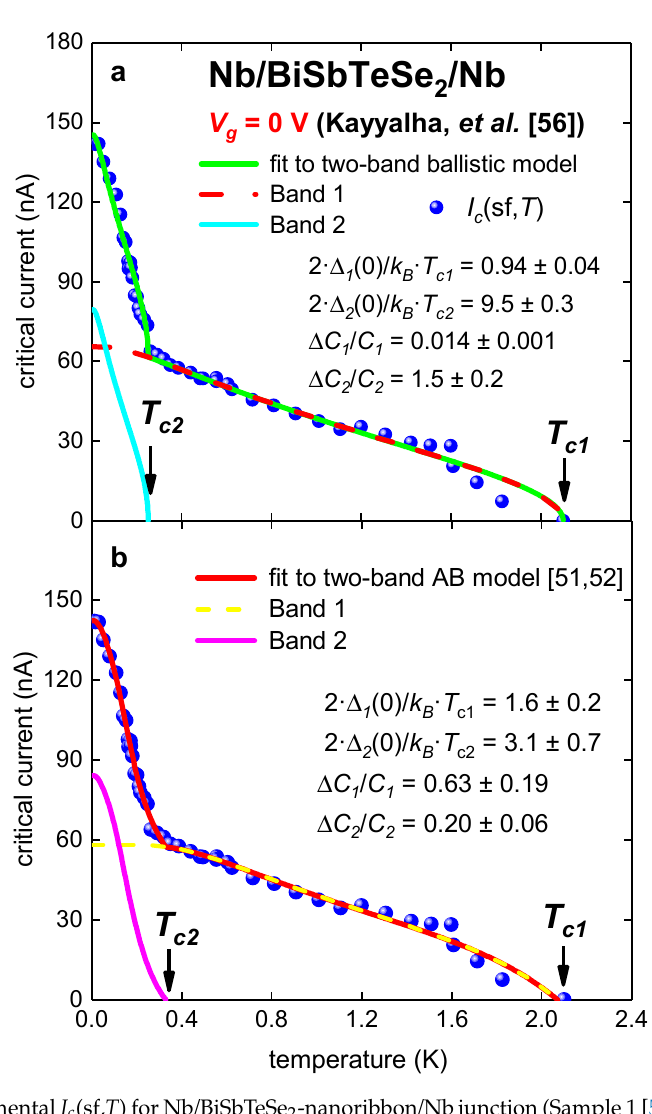
Figure 4. Experimental I c (sf, T ) for Nb / BiSbTeSe 2 -nanoribbon / Nb junction (Sample 1 [56]) at gate voltage V g = 0 V. ( a ) Ballistic model, fit quality is R = 0.992; ( b ) modified AB model [51,52]. Derived parameters: R n1 = 3.9 ± 0.4 k Ω , R n2 = 0.81 ± 0.15 k Ω , fit quality is R = 0.9965. Table 4. Deduced parameters for for Nb/BiSbTeSe 2 -nanoribbon/Nb junction (Sample 1 [56]) at V g = 0 V from fit to two-band Titov and Beenakker (TB) [53] and Ambegaokar and Baratoff (AB) [7,8] models.